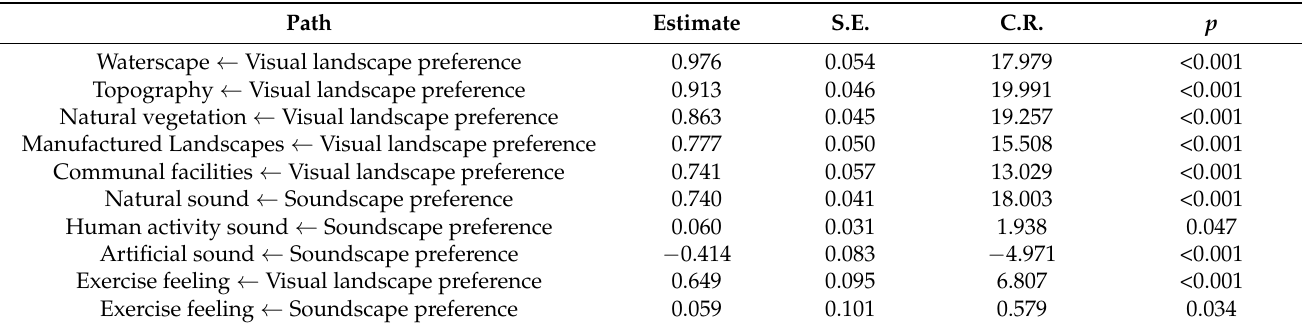
Table 9. Path analysis of modified structural equation